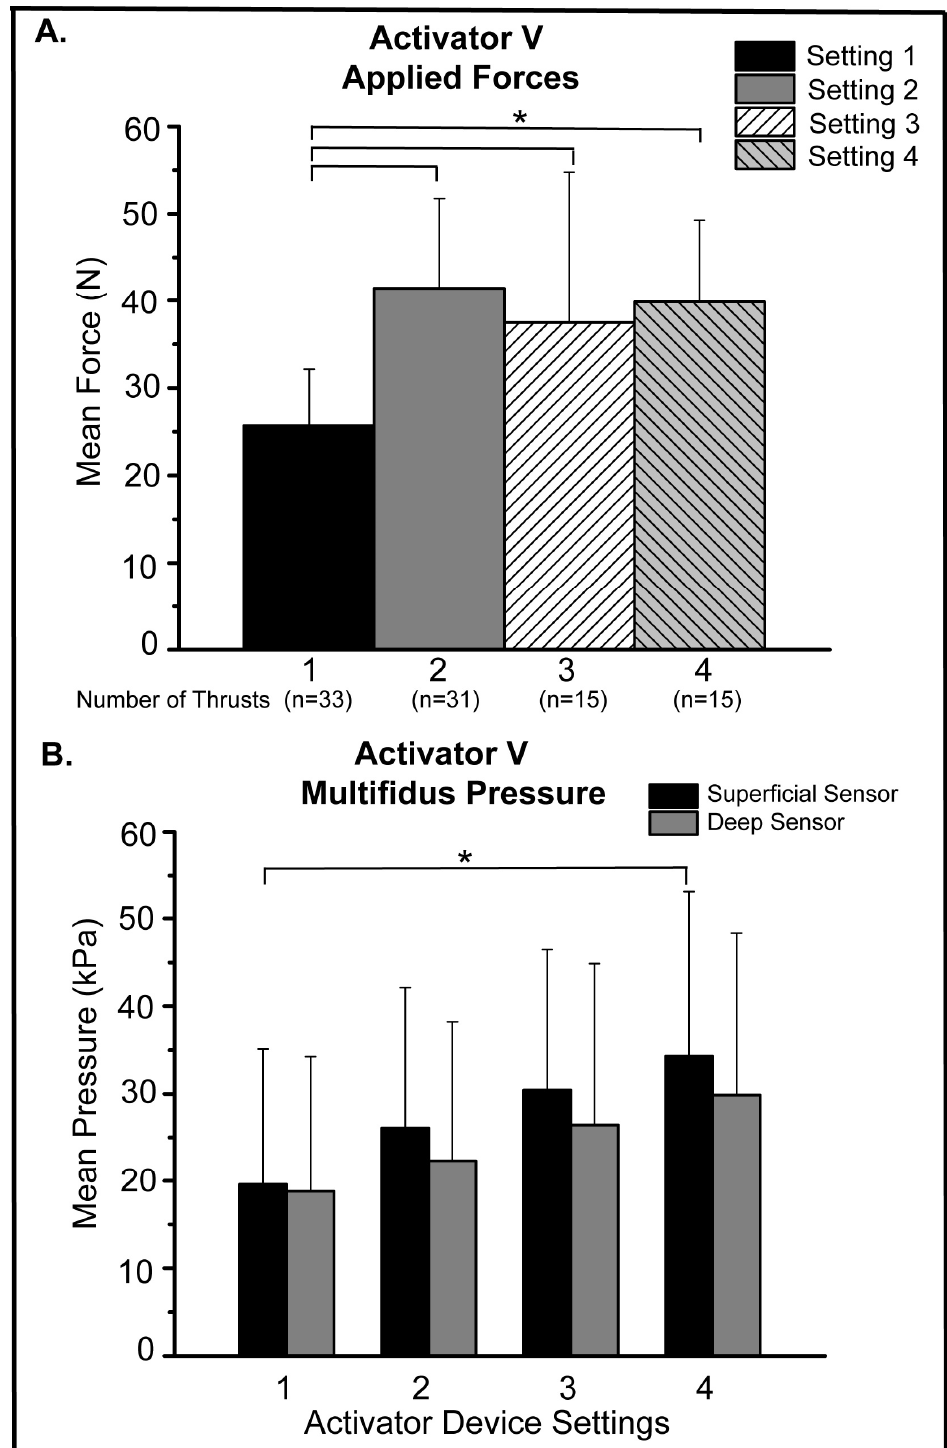
Figure 2. Activator V Applied Force and Intramuscular Pressure. ( A ) Mean Activator V L7 spinous applied forces at devices settings of 1–4, (* p ≤ 0.003); ( B ) mean superficial and deep intramuscular pressure at Activator V device settings 1–4 (* p = 0.024).